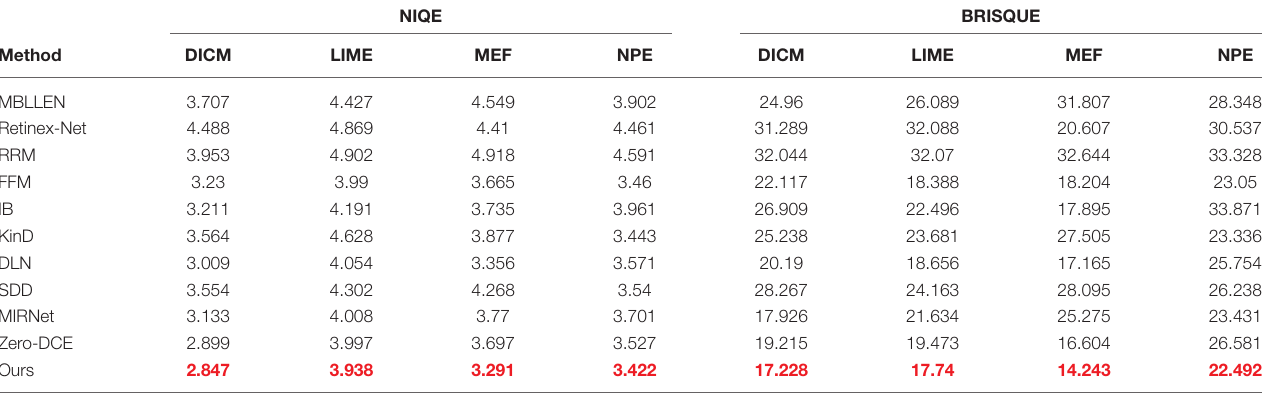
TABLE 3 | Performance of the following low-light enhancement methods calculated on the DICM, LIME, MEF, and NPE public datasets using the no-reference metrics NIQE and BRISQUE.